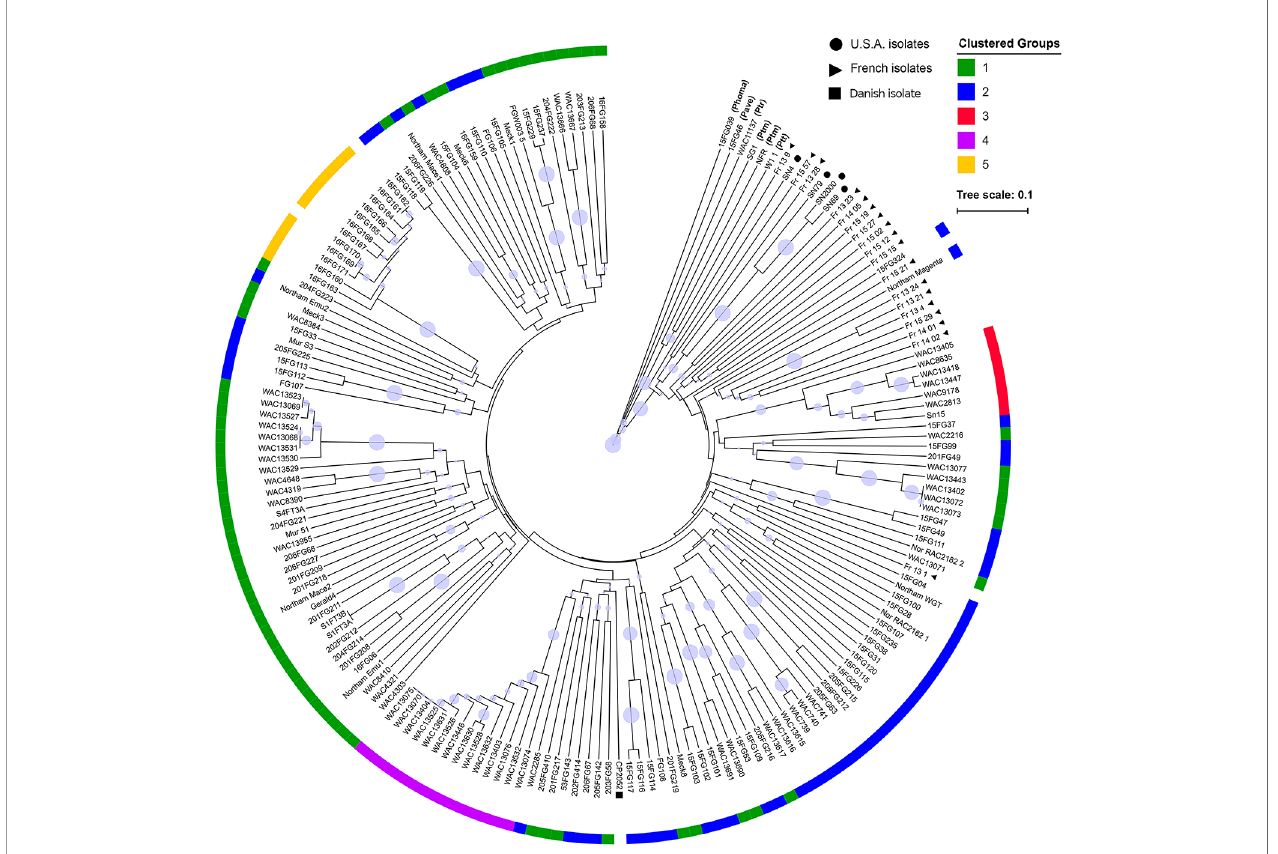
FIGURE 2 | A UPGMA tree of 184 P . nodorum and other species constructed using Bruvo's distance with non-parametric bootstrapping. Non-shading blocks indicate the absence of effector genes ( Table S1 ). Clades with bootstrap support < 30% are collapsed into polytomies. Branch bubbles represent bootstrap support for the remaining clades (30% – 100% support). Clustered groups were constructed from DAPCs. Non- P. nodorum isolates have their abbreviated species names in brackets. Isolates from France, USA and Denmark are indicated by black circles, triangles and a square, respectively. No group assignment was done for the isolates 16FG162 and 16FG170 as they were removed from the cluster analysis due to